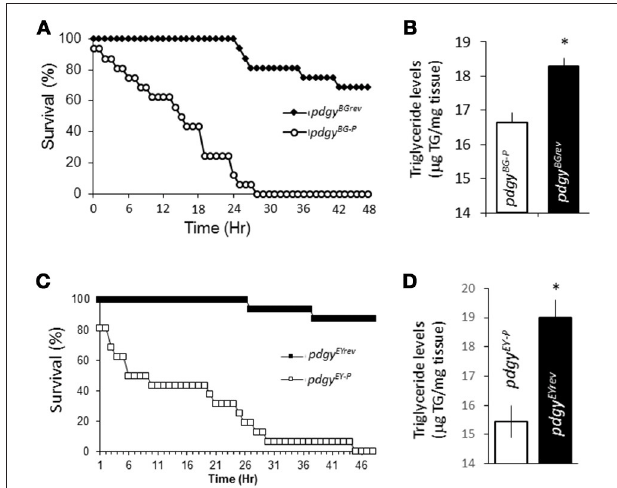
FIGURE 3 | pdgy mutants display metabolic phenotypes. (A) Under starvation conditions, the pdgy BG − P displayed decreased survival compared to background controls, pdgy BGrev . (B) pdgy BG − P had decreased lipid stores compared to background controls. (C,D) Starvation phenotypes compared to its background control ( pdgy EYrev ) as the pdgy BG − P (D) and pdgy EY − P shows a similar triglyceride phenotypes. * p <